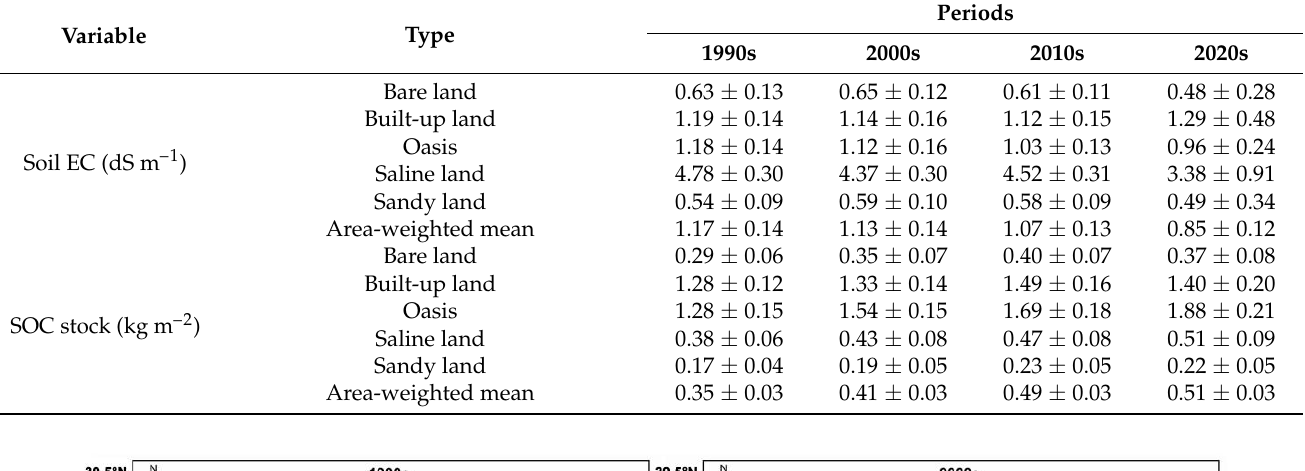
Table 2. Summary of soil EC and SOC stock by land use and land cover type.